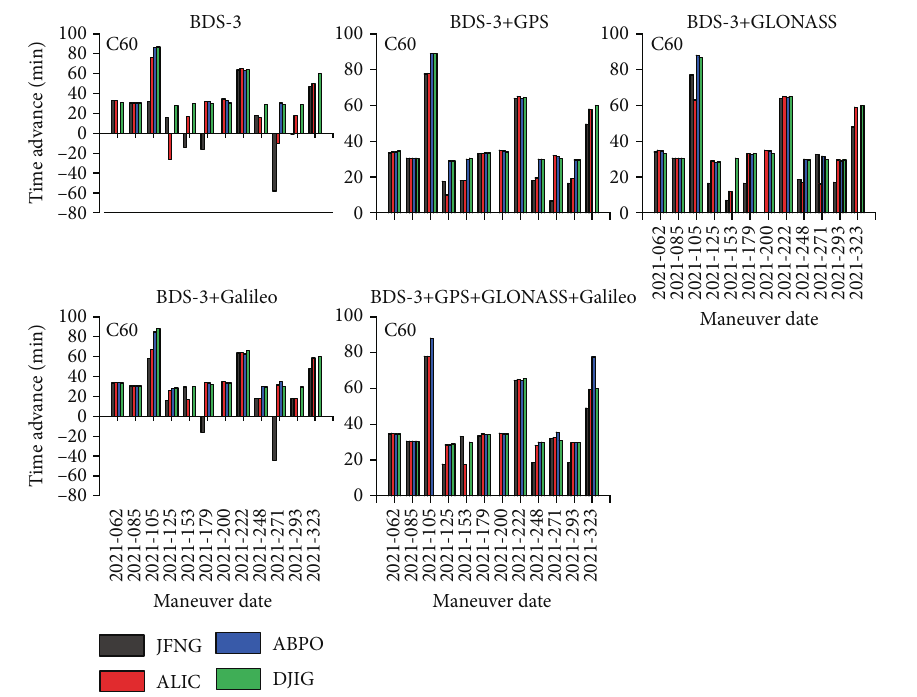
Figure 16: Comparison of detection results for C60 maneuvering start time by di ff erent stations using the same combined